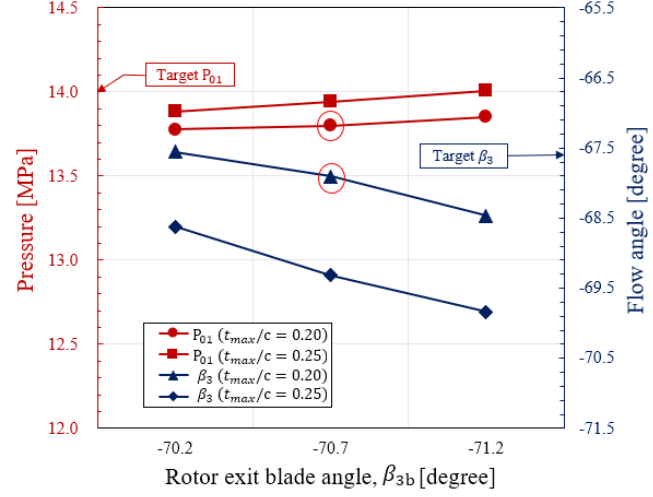
Figure 14. Pressure ( 𝑃 01 ) and flow angle ( 𝛽 3 ) according to the second-stage rotor optimization of the radial outflow turbine.